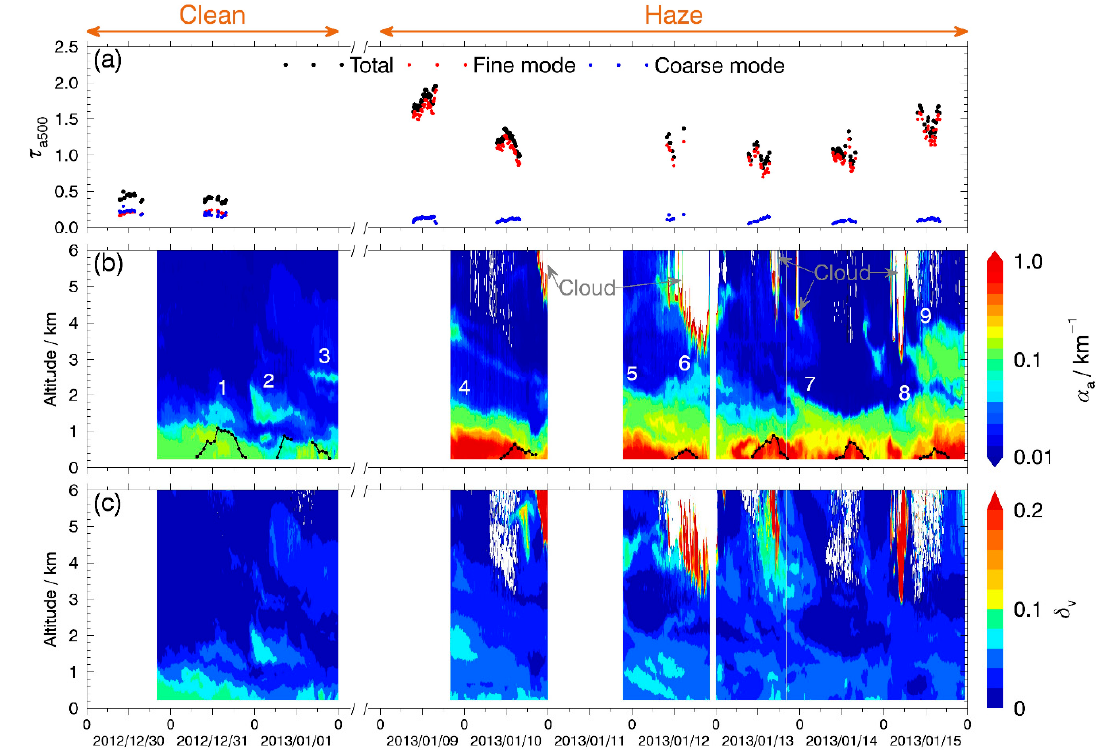
Figure 4. ( a ) Time series of sun photometer columnar total (black dots), fine (red dots) and coarse mode AOD (blue dots) at 500 nm. Time–height plot of ( b ) the aerosol extinction coefficient ( α a ) and ( c ) volume depolarization ratio ( δ v ) at 532 nm from lidar measurements during the observation period. In panel ( b ), the 9 elevated aerosol layers are indexed with numbers above them, and several clouds are indicated. The convective boundary layer heights are retrieved with the variance method [24] using lidar signals and plotted in panel ( b ) as the black curve with dots.